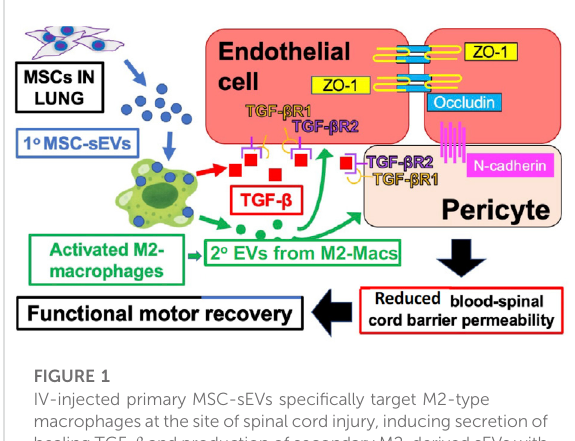
FIGURE 1 IV-injected primary MSC-sEVs speci fi cally target M2-type macrophagesatthesiteofspinal cordinjury,inducing secretionof healing TGF- β and production of secondary M2-derived sEVs with surface TGF- β to induce and bind TGF- β R2 on local vascular cells, and inducing the production of endothelial cell junctional proteins to restore the blood – spinal cord barrier